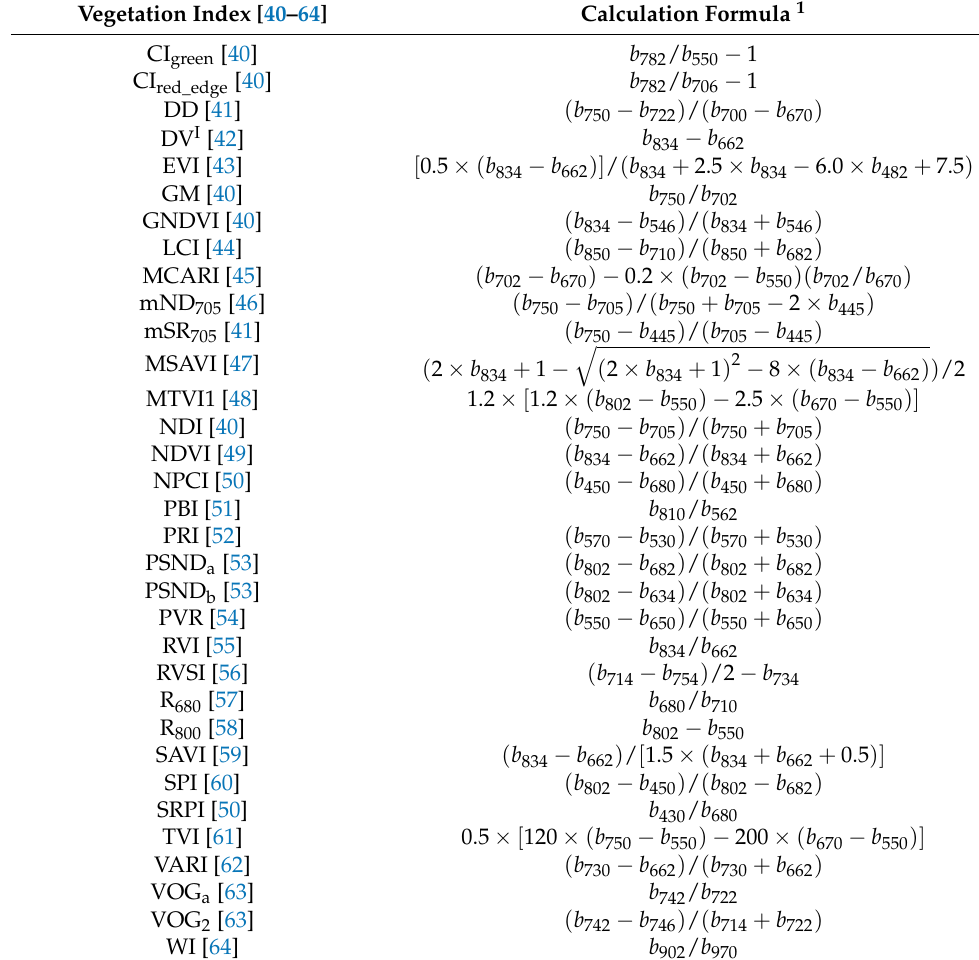
Table 1. Calculation formulae of vegetation